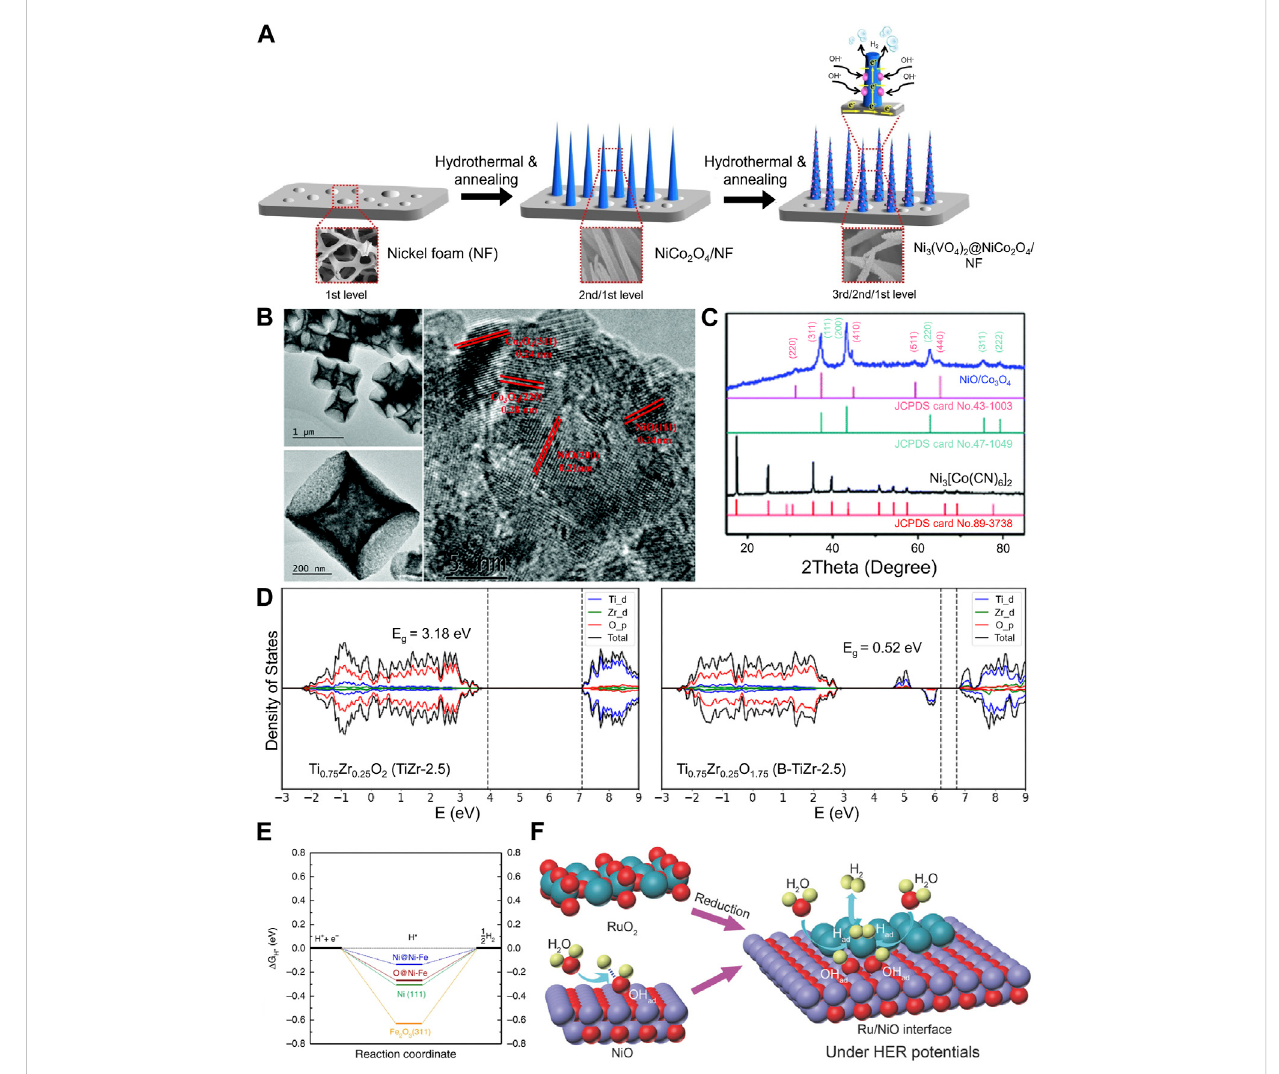
FIGURE 2 (A) Schematic diagram of the steps involved in the fabrication of a three-dimensional hierarchical structure of Ni 3 (VO 4 ) 2 @NiCo 2 O 4 /NF. In the fabricationprocess,NiCo 2 O 4 nanowiresweregrownonnickelfoambyahydrothermalprocess,andNi 3 (VO 4 ) 2 wasthengrownonNiCo 2 O 4 nanowiresby a hydrothermal process reproduced with permission from Shang et al. (2017). (B) HRTEM image of the heterostructured NiO/Co 3 O 4 concave microcuboidwhichshowsindividuallatticesofCo 3 O 4 andNiO. (C) IndividuallatticewasalsosupportedbyXRDmeasurementwhichshowsNiOand Co 3 O 4 peaks coexisted in the sample [reproduced with permission from Wei et al. (2019)]. (D) Density of states of Ti 0.75 Zr 0.25 O 2 and partially